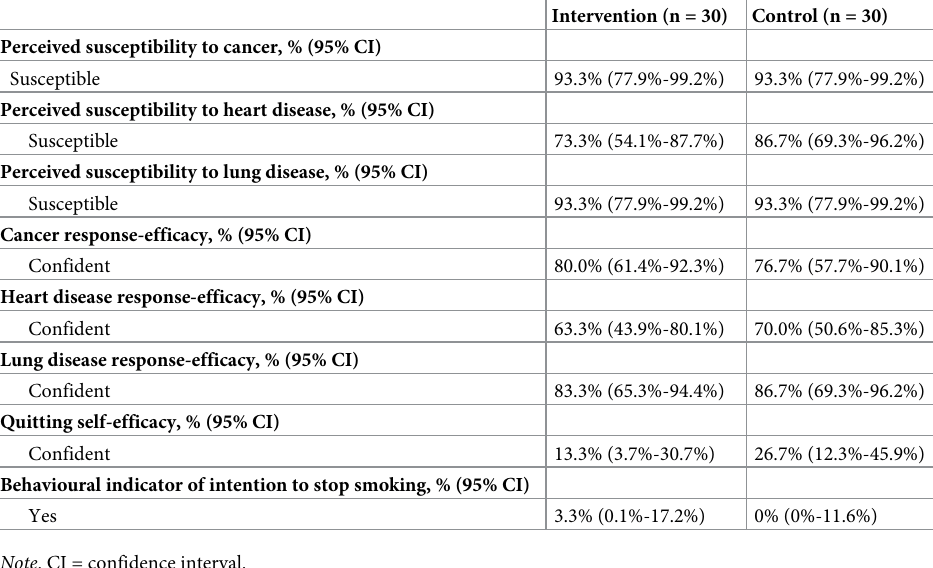
Proximal quitting outcomes in the intervention and control arm were comparable (see Table 2). In the sensitivity analysis with the proximal quitting outcomes operationalised as continuous variables (except for intention to stop), there were no significant differences between the intervention and control scenarios, with the exception of quitting self-efficacy (see S1 Table). Quitting self-efficacy was significantly greater in the control (M = 3.03, SD = 1.07) compared with the intervention arm (M = 2.30, SD = 0.95), p = 0.006. Table 2. Proximal quitting outcomes (analytic sample, N =